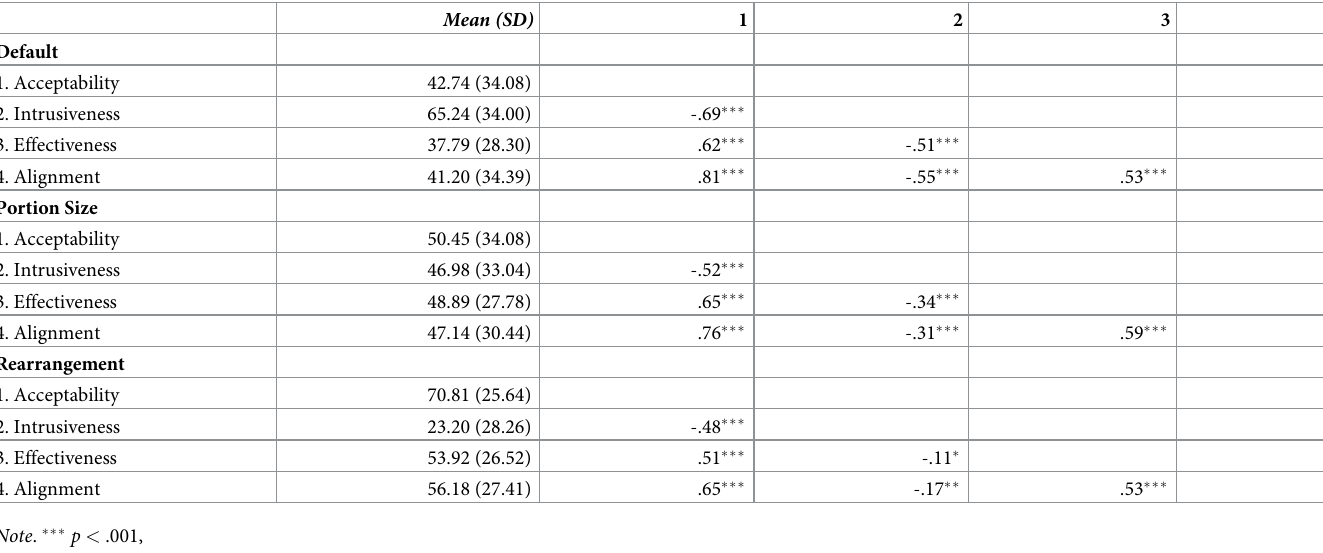
Table 3. Descriptives and correlation coefficients for the ratings of the three types of